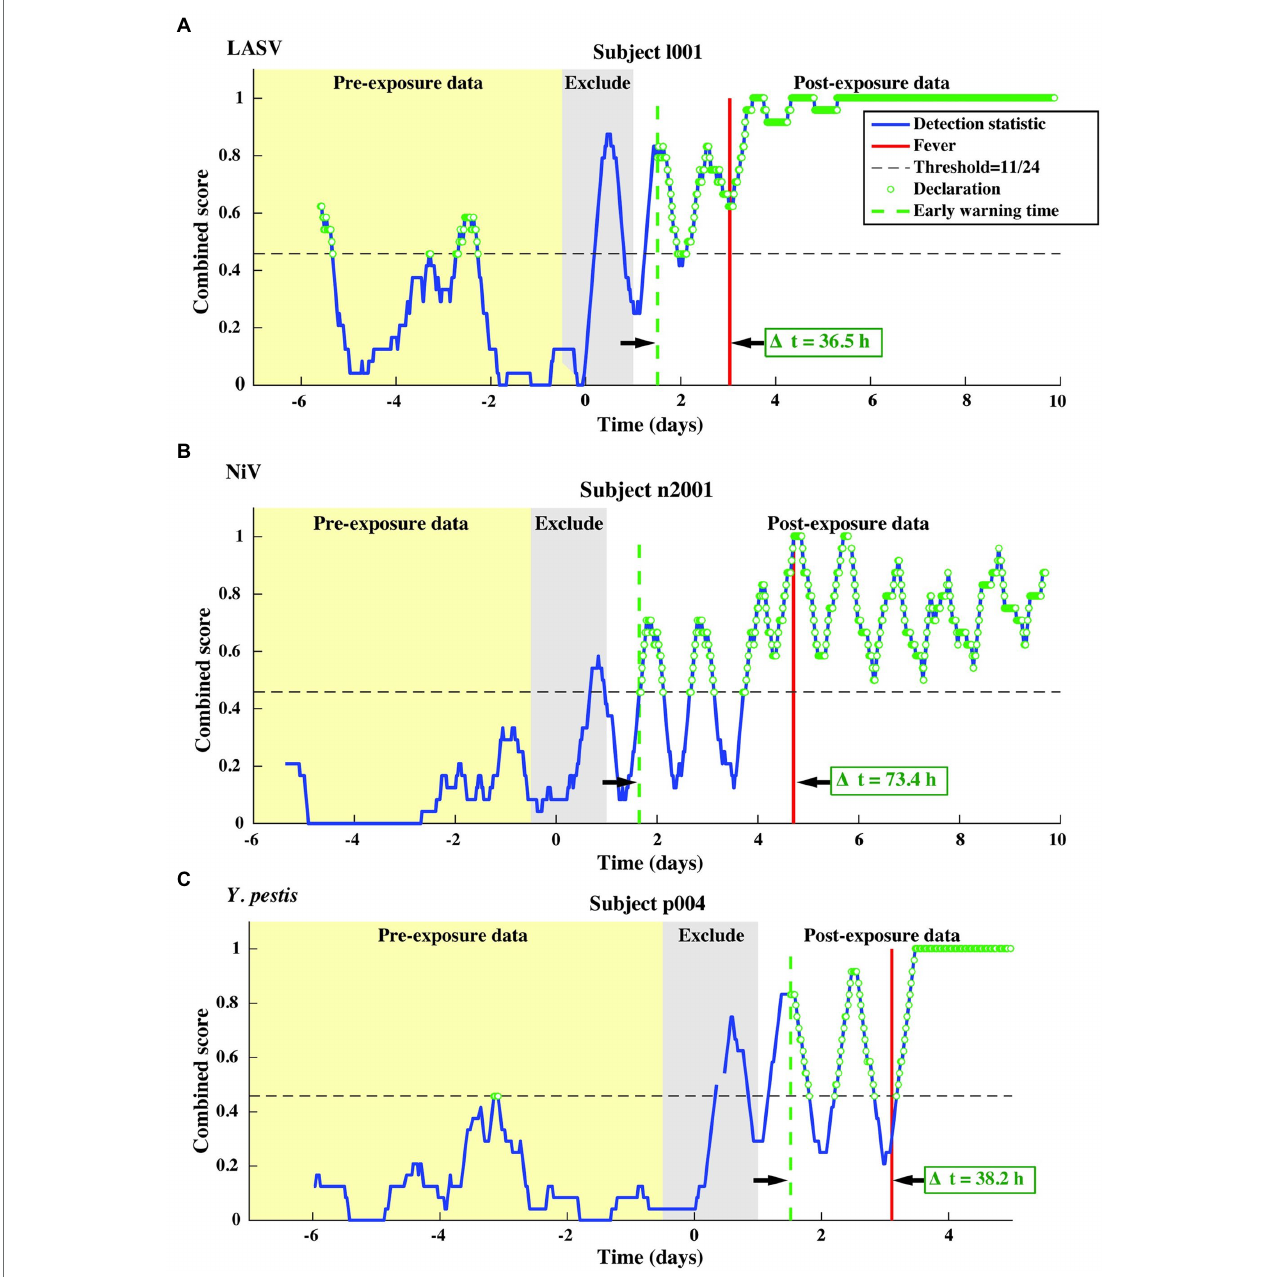
FIGURE 7 | Representative single subject outputs from each of three independent datasets. Scores and declarations for: (A) LASV, (B) NiV, and (C) Y. pestis . Declarations made in the pre-exposure data represent false positives.